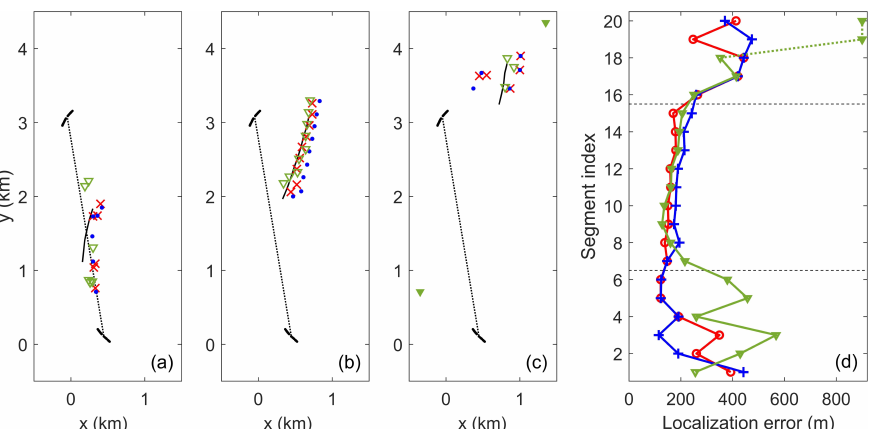
Figure 10. (Color online) ( a – c ) Position estimates of GMA (red symbols), N-MUSIC (blue symbols) and the relative-amplitude MFP processor (green symbols) for Sections 1–3, respectively. Solid black line indicates true source track in corresponding section. ( d ) Localization errors of GMA (red symbols), N-MUSIC (blue symbols) and the relative-amplitude MFP processor (green symbols). Results are with 198 Hz. Filled green symbols in ( c ) indicate the estimate with x value beyond this area. Filled green symbols in ( d ) on the dotted lines correspond to the estimates with error larger than 1